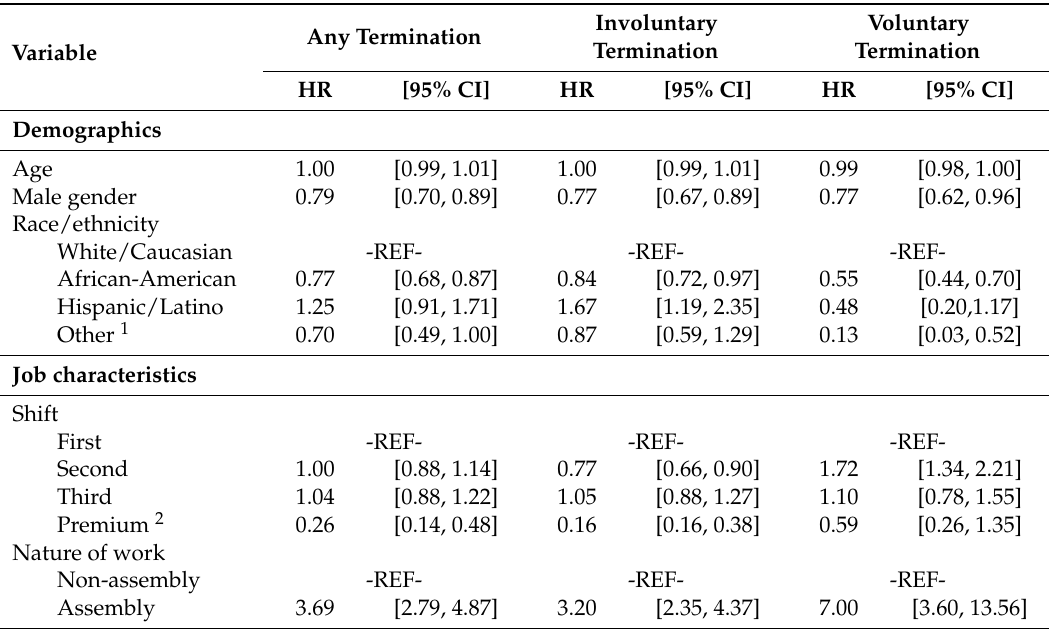
Table 2. Crude associations between demographic and job characteristic variables and employment termination within the 60-day probationary